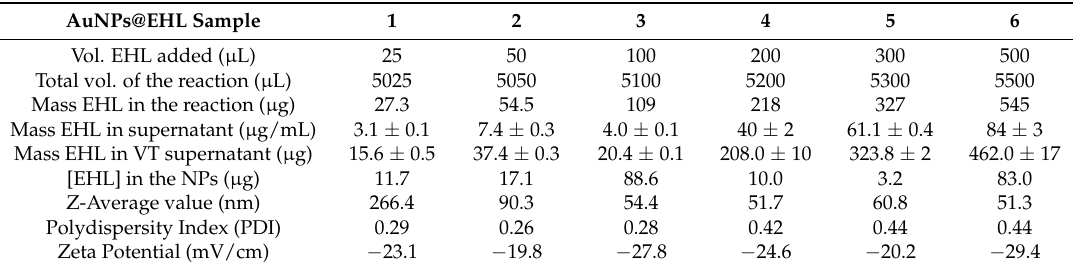
Figure 1. UV-Vis spectrum ( a ) histogram ( b ) and low magnification TEM images ( c , d ) of AuNPs@Citrate. The histogram is derived from measurements of 300 nanoparticles made in ImageJ software. Table 1. AuNPs@EHL solution composition for each experiment, DLS, and Zeta Potential Values and protein amount on the nanoparticles ([EHL] = concentration of EHL).